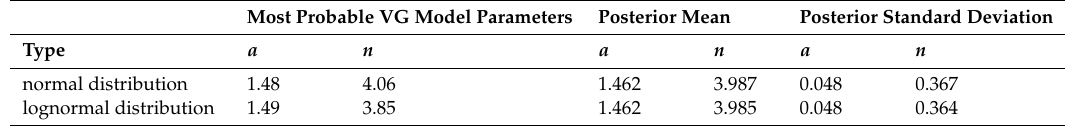
Figure 12. Update results when the prior distribution is a normal distribution: ( a ) prior distribution; ( b ) posterior distribution. Table 3. Impact of prior distribution on update